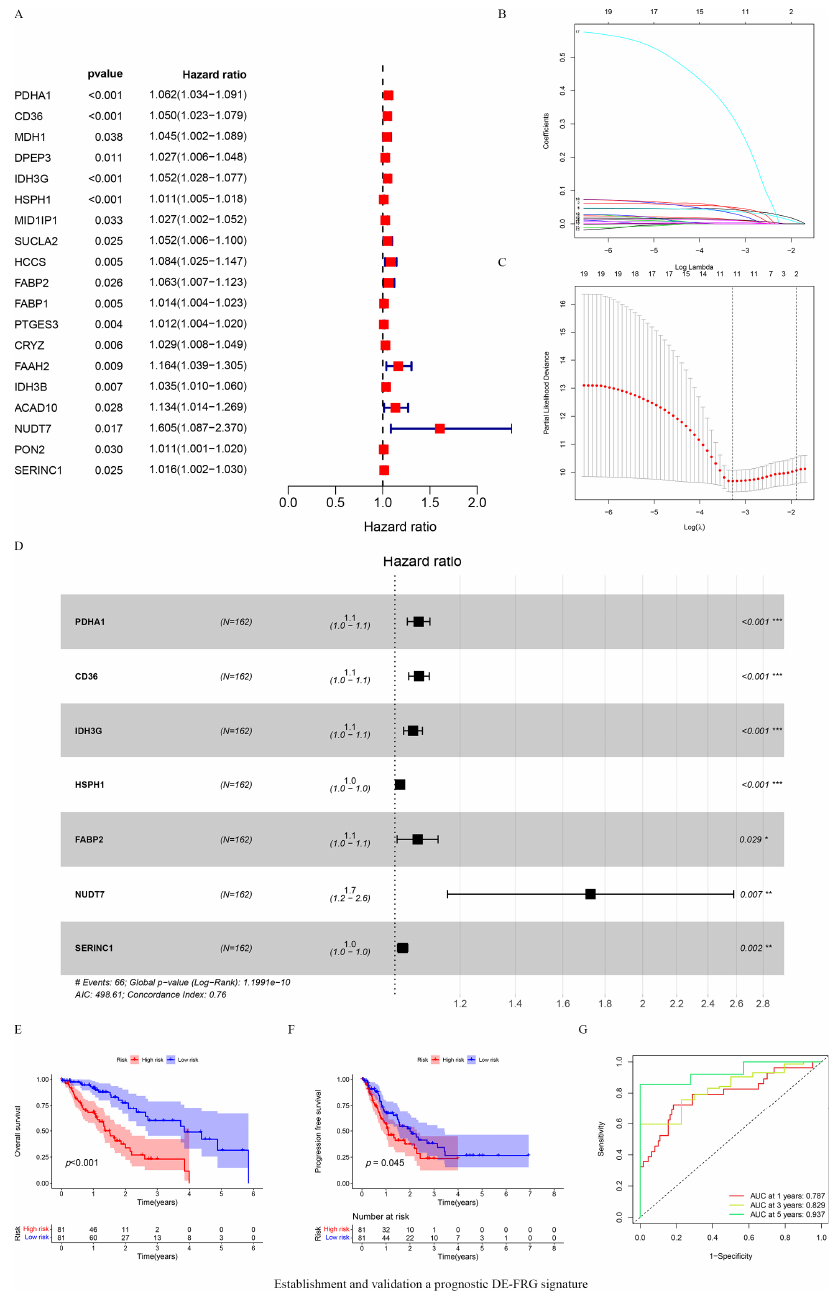
Figure 2. Establishment and validation a prognostic DE-FRG signature. ( A ) 19 genes were associated with the clinical outcomes of ESCA patients based on univariate Cox regression analysis; Red squares represnt Hazard Ratio (HR) value. ( B ) LASSO coefficient profiles of the 19 selected fatty acid metabolic genes; ( C ) The best parameter (lambda) in the LASSO-Cox model; the red dots indicates the partial probability of deviation values, the gray lines indicates standard error (SE). ( D ) 7 genes were eventually identified as prognosis related biomarkers based on multivariate Cox regression analysis; ESCA patients were divided into high-risk (n = 80) and low-risk ( n = 80) groups based on the median risk score. * p <0.05, ** p <0.01, *** p <0.001. Black squares represent Hazard Ratio (HR) value. ( E , F ) Kaplan–Meier survival analysis was performed to assess the difference in OS and PFS between the high-risk and low-risk group; ( G ) ROC curves of risk model for predicting overall survival at 1, 3, and 5